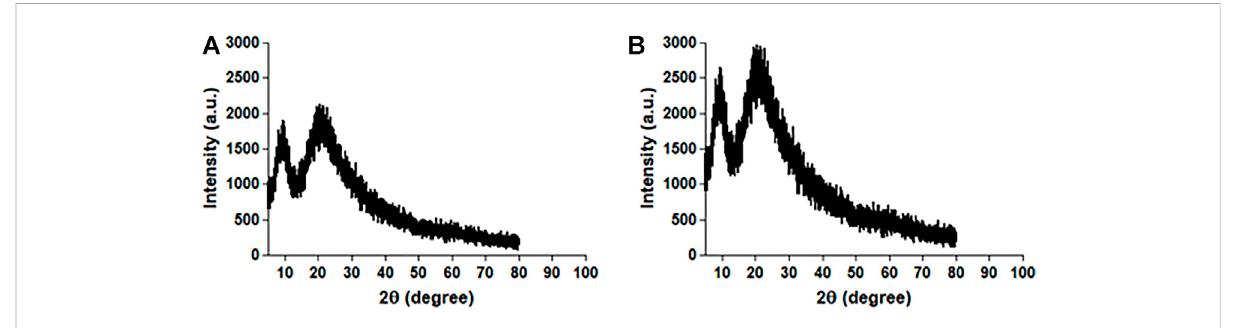
FIGURE 5 XRD pattern of (A) native HSA and (B) 4-Cl-OPD modi fi ed